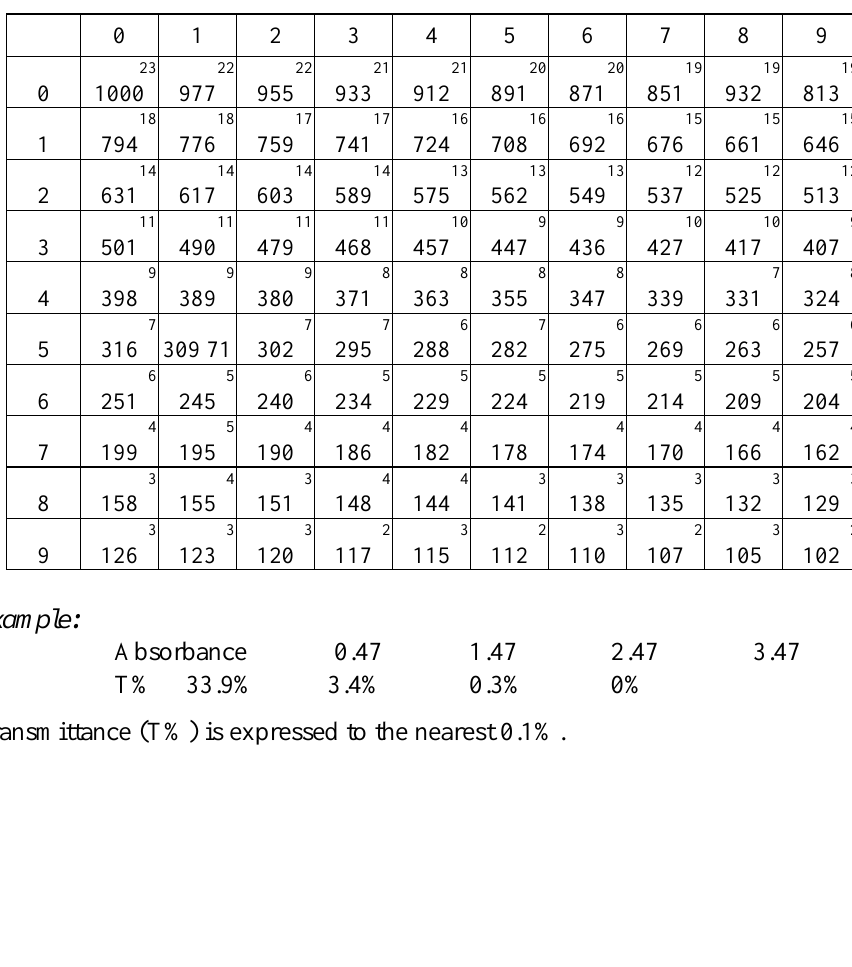
Converting absorbance into transmittance